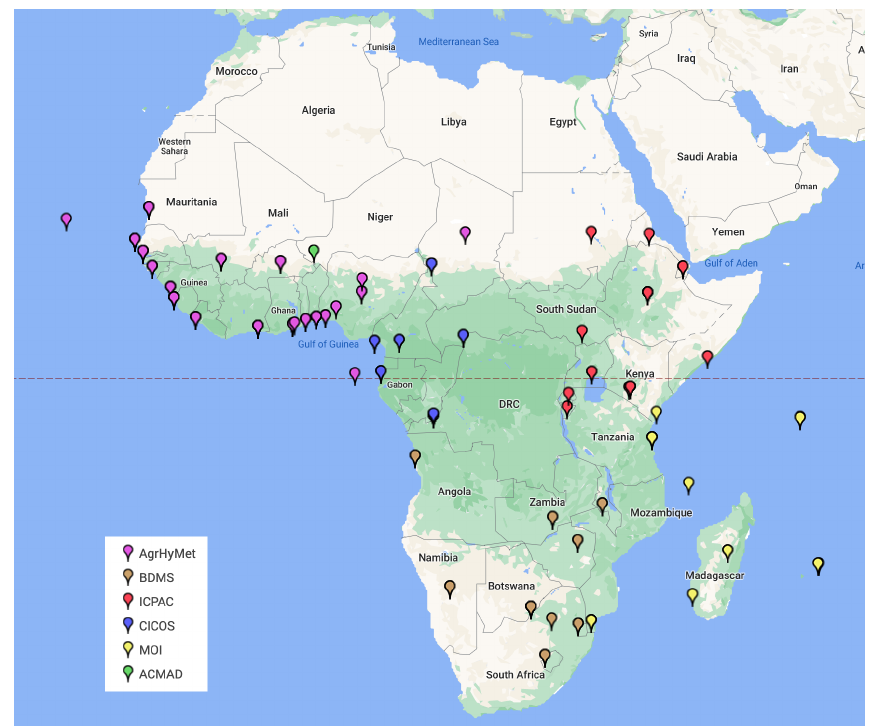
Figure 2. Distribution of MESA stations in the African regions participating in the MESA project. The stations are associated to the 5 Regional Implementation Centers, namely AgrHyMet, CICOS, BDMS, ICPAC and MOI, in Western, Central, Southern, Eastern Africa and in Indian Ocean regions. ACMAD was in charge of climate services at continental